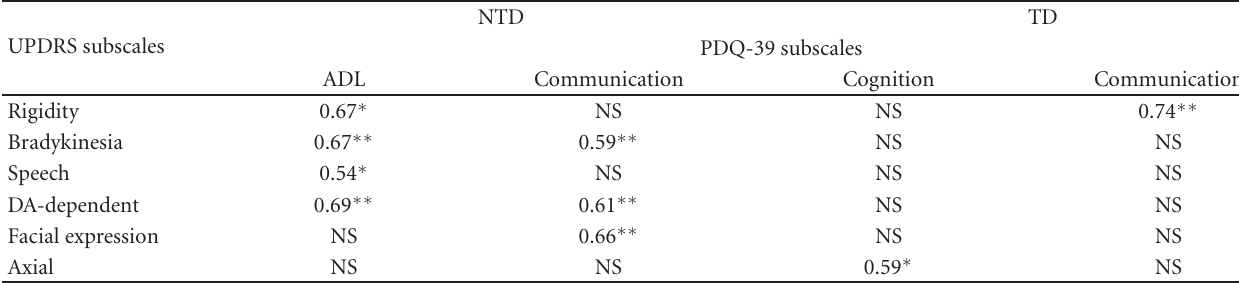
Table 2: Significant correlations between PDQ-39 and UPDRS subscales for NTD and TD subjects.